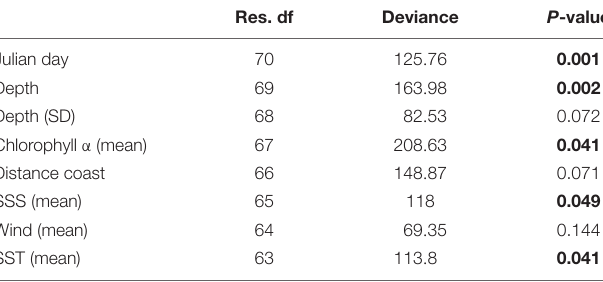
TABLE 2 | ANOVA table from the most parsimonious multivariate generalized linear model showing variance explained by each variable (deviance) and the significance after 999 PIT-trap resampling iterations ( P